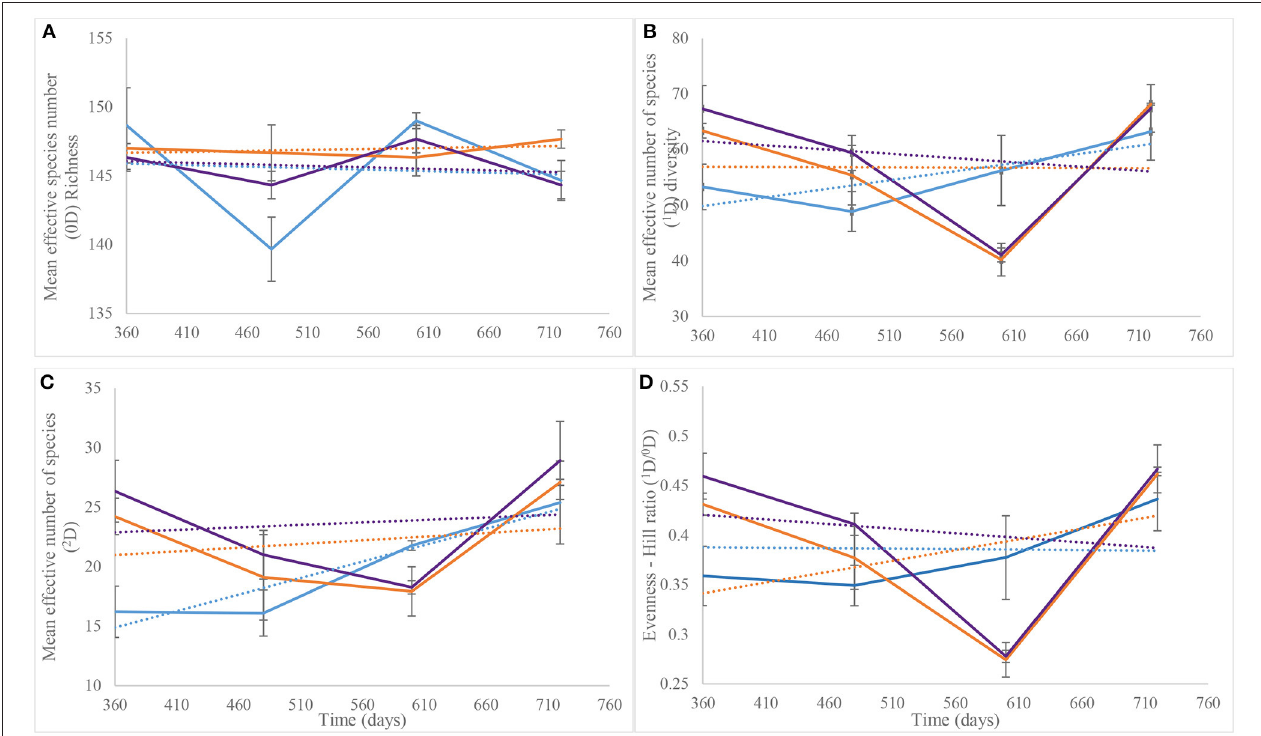
FIGURE 7 | Average ( n = 3) taxa richness ( 0 D, A ), common taxa diversity ( 1 D, B ), dominant taxa diversity ( 2 D, C ), and evenness ( 1 D/ 0 D, D ) for bacterial communities of control ( (cid:4) ), leaf litter ( (cid:4) ) and piglet ( (cid:4) ) associated soils on days 360, 480, 600, and 720. The Hill numbers were calculated using species that were identified from next generation sequencing. Each datum point is the mean of triplicate samples. Error bars are SEM.